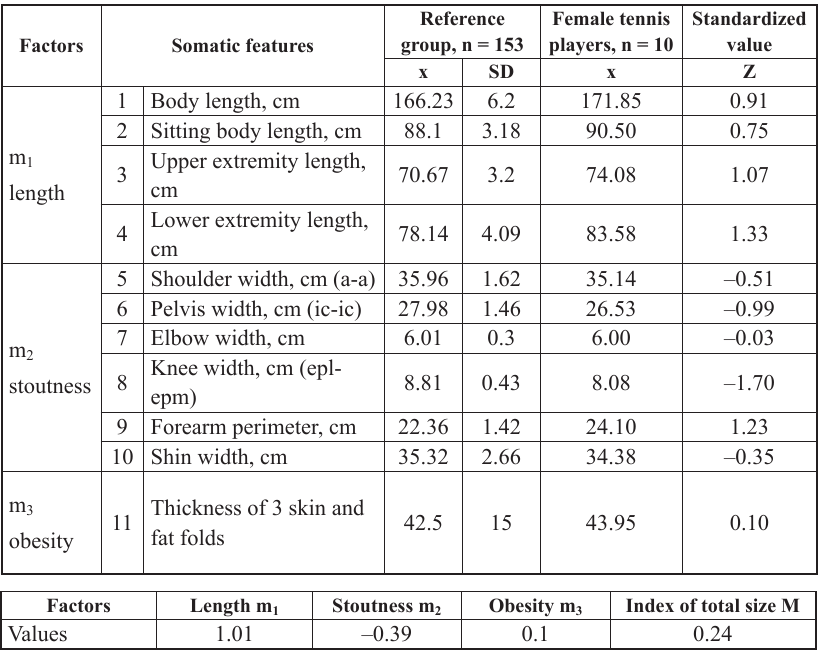
Table 3. Factors of the body compo- sition in members of female national tennis team of Poland (n =